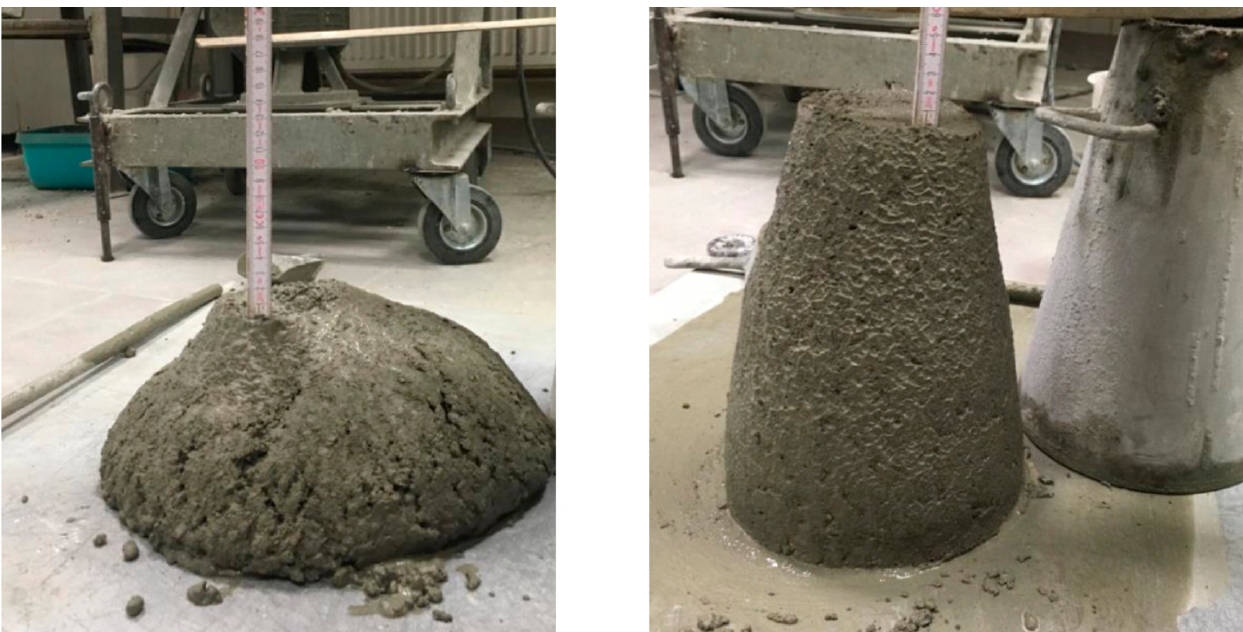
Figure 5. Photograph of the difference in consistency measured with the slump test method between the REF 1 series ( left photo ) and SAP SH50 ( right photo ).